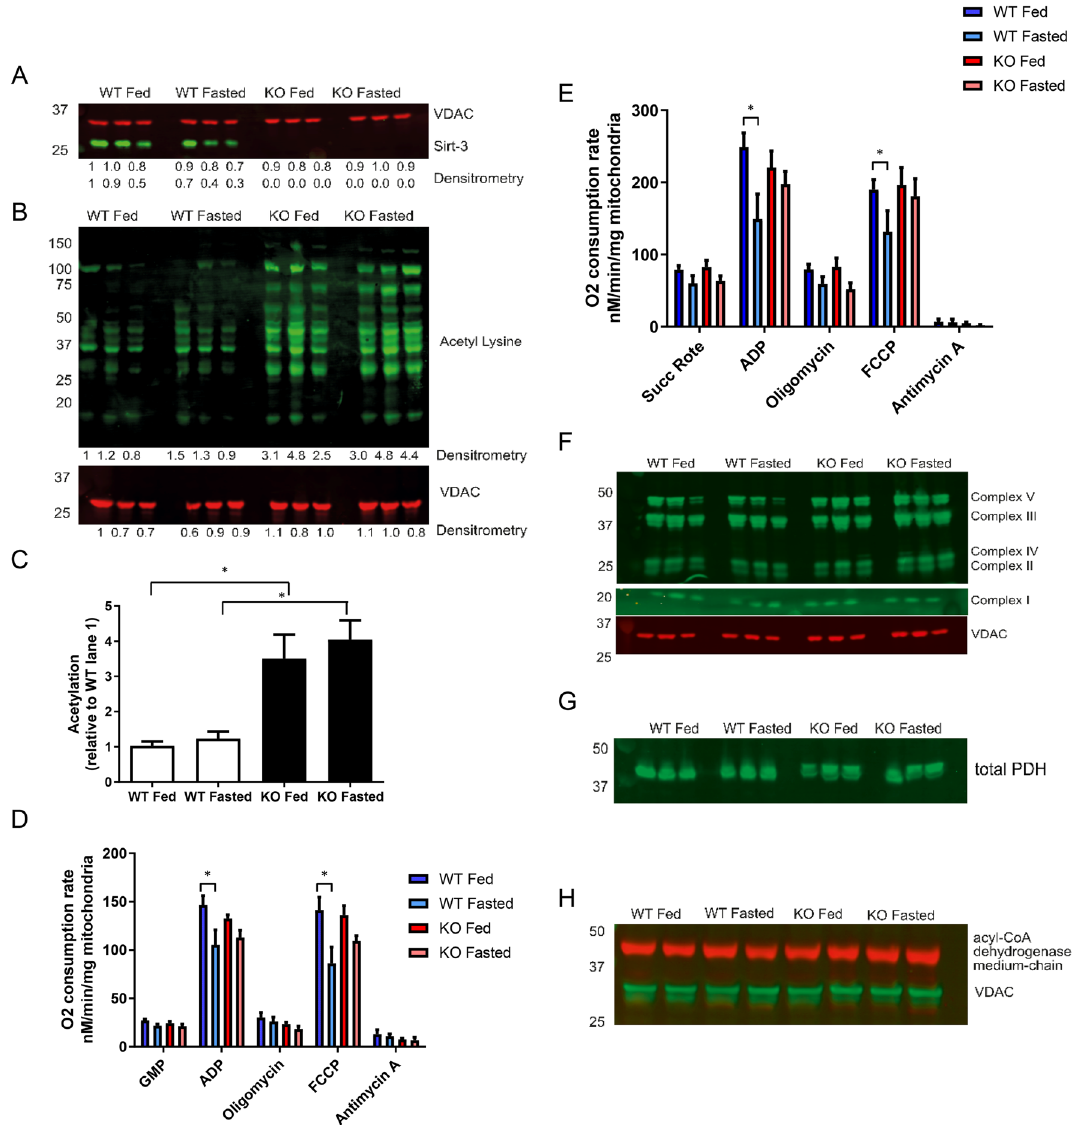
Figure 4. Fasting reduces maximal mitochondrial oxygen consumption in WT, but not SIRT3 KO mitochondria. Cardiac mitochondria from SIRT3 KO mice are hyperacetylated compared to WT mitochondria, with no change induced by transition from fed to fasting. No differences in mitochondrial subunit expression, PDH or Acetyl Co Dehydrogenase are observed. ( A ) No significant changes SIRT3 expression are observed in WT fed vs fasted mice, whilst genetic SIRT3 KO mice lack SIRT3. N = 3/group. Error bars indicate S.E.M. One-Way ANOVA, P > 0.05 (comparing within genotypes). ( B ) SIRT3 KO mitochondrial proteins are significantly hyperacetylated vs WT mitochondrial proteins, whilst the transition from fed to fasting does not alter mitochondrial acetylation. N = 3/group. Error bars indicate S.E.M. One-Way ANOVA with Tukey post-test, *P ≤ 0.05. ( C ) Quantification of pan-mitochondrial acetylation reveals SIRT3 KO mitochondria are significantly hyperacetylated vs mitochondria from WT hearts. N = 3/group. Error bars indicate S.E.M. One-Way ANOVA with Tukey post-test, *P ≤ 0.05. ( D ) Fasting significantly reduces Complex I driven maximal-coupled, and uncoupled respiration in WT cardiac mitochondria, but not SIRT3 KO cardiac mitochondria. N = 6/group. Error bars indicate S.E.M. One-Way ANOVA with Tukey post-test, *P ≤ 0.05. ( E ) Fasting significantly reduces Complex II driven maximal-coupled, and uncoupled respiration in WT cardiac mitochondria, but not SIRT3 KO cardiac mitochondria. N = 6/group. Error bars indicate S.E.M. One-Way ANOVA with Tukey post-test, *P ≤ 0.05. ( F ) The transition from fed to fasting does not alter the expression of mitochondrial subunits isolated from either WT or SIRT3 KO mice hearts. N = 3/group. ( G ) No differences in the expression of pyruvate dehydrogenase (PDH) are observed in cardiac mitochondria isolated from fed/fasted WT and SIRT3 KO mice. N = 3/group. ( H ) No differences in the expression of medium chain acyl-CoA dehydrogenase (MCAD) are observed in cardiac mitochondria isolated from fed/fasted WT and SIRT3 KO mice. N =